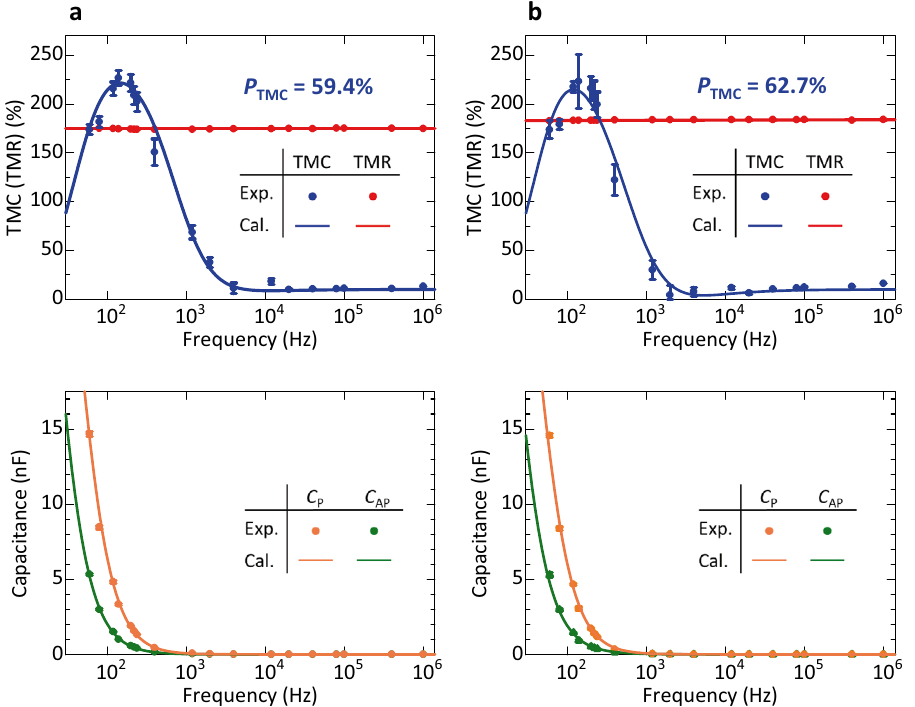
Figure 3. Frequency characteristics of TMC, TMR, and C P(AP) . ( a , b ) TMC, TMR (upper panels), and C P(AP) (lower panels) for an Fe/MAO/Fe MTJ of samples A and B, respectively. The solid points are experimental data and solid lines represent the calculation results based on DF model, Eq. (1). The error bars are standard deviations. The experimental data are reasonably fitted by the model for both